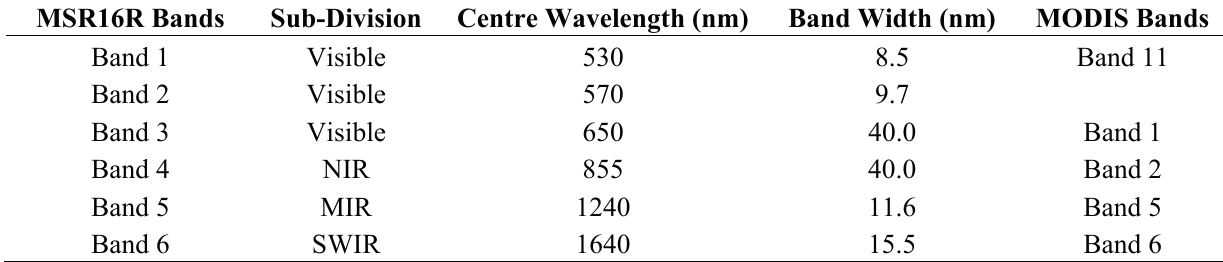
Table 1. Wavelength of spectral bands equipped in the CROPSCAN 16 (MSR16R) and their equivalent bands of Moderate Resolution Imaging Spectroradiometer